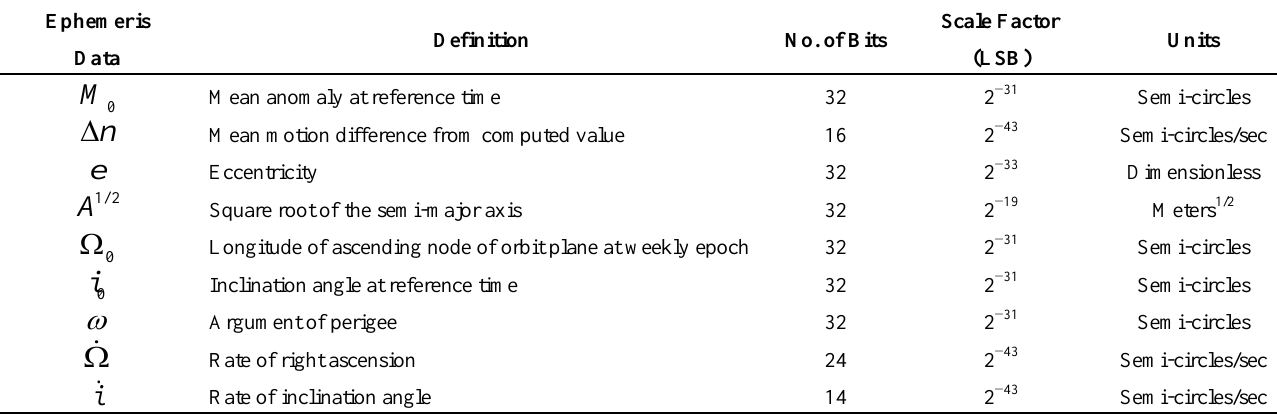
Table 1. Selected ephemeris parameter of GPS L1